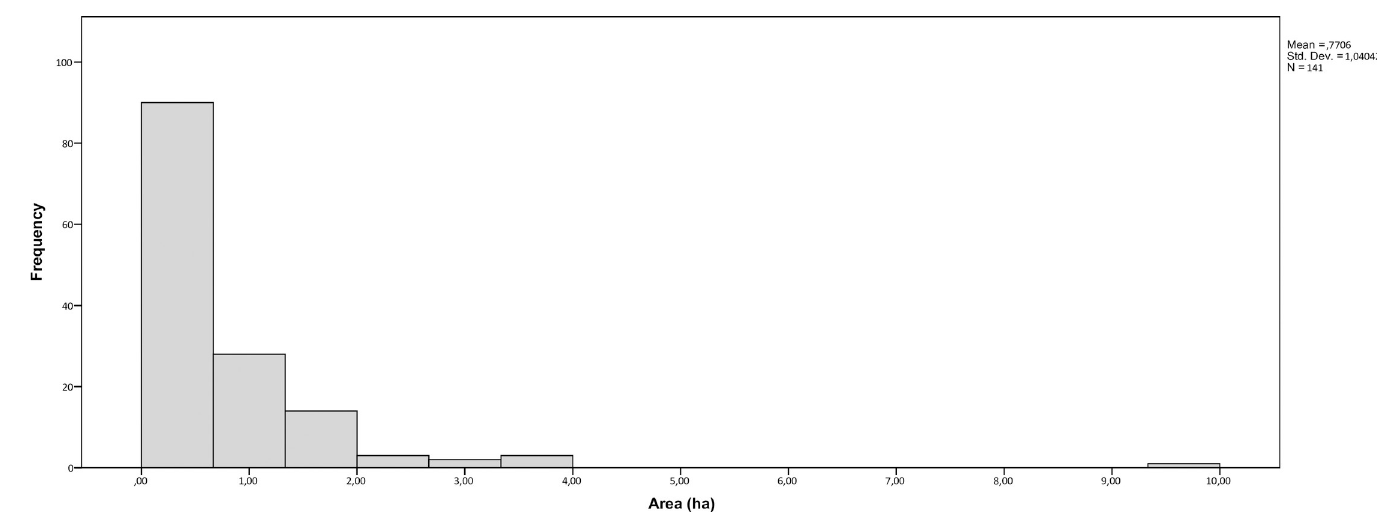
Fig 2. Histogram showing the surface area range of mounded